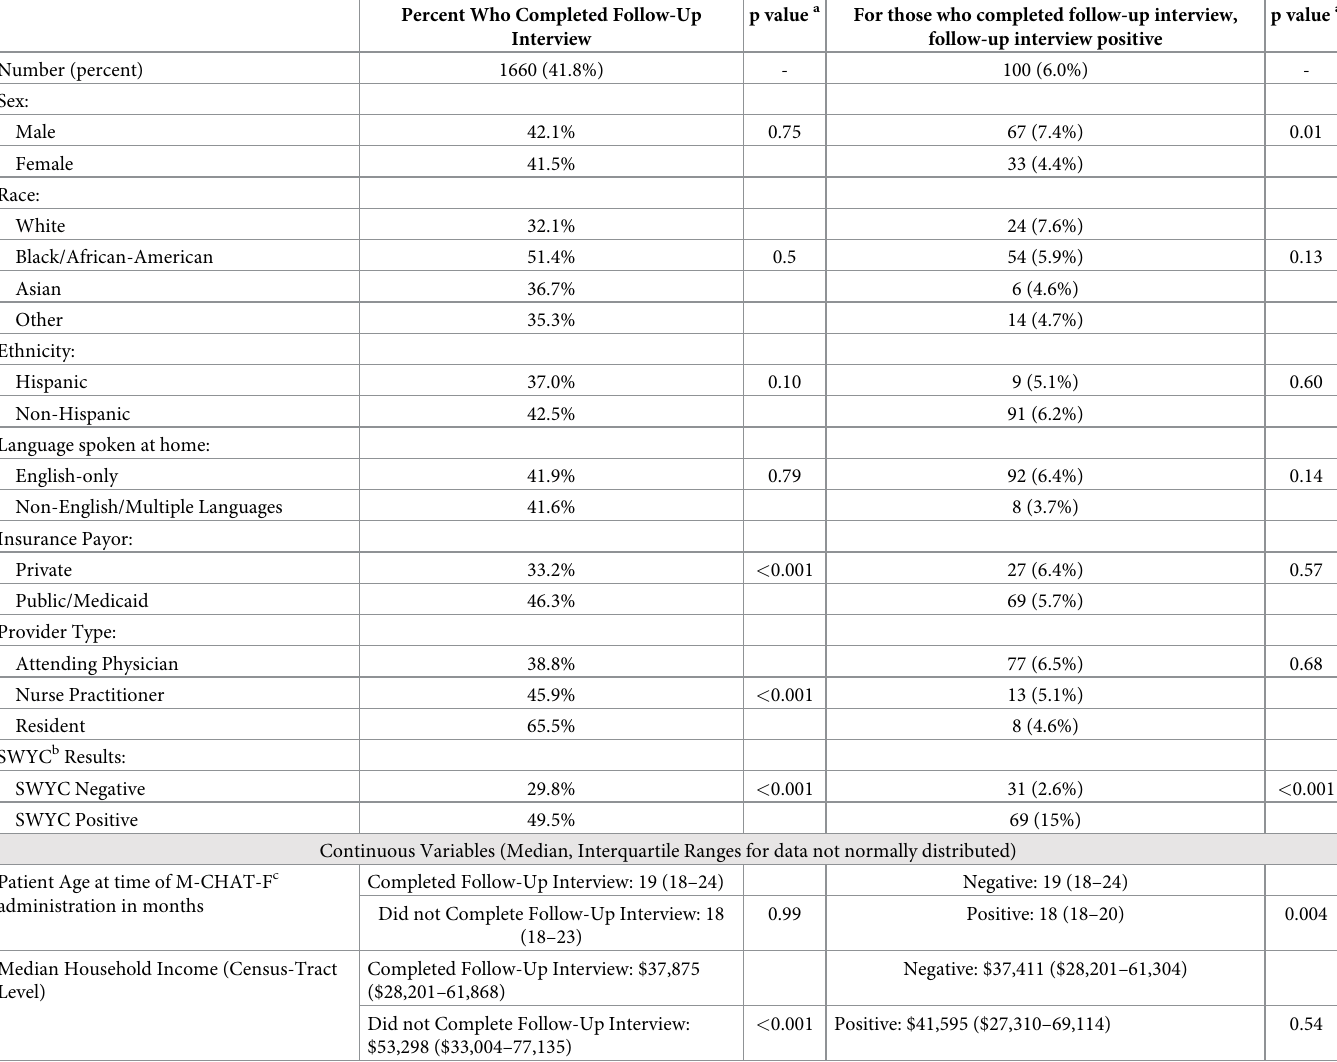
Table 2. Regression analysis: Socio-demographic factors associated with completion of follow-up interview (n = 3969), positive follow-up interview (n = 1660). Percent Who Completed Follow-Up